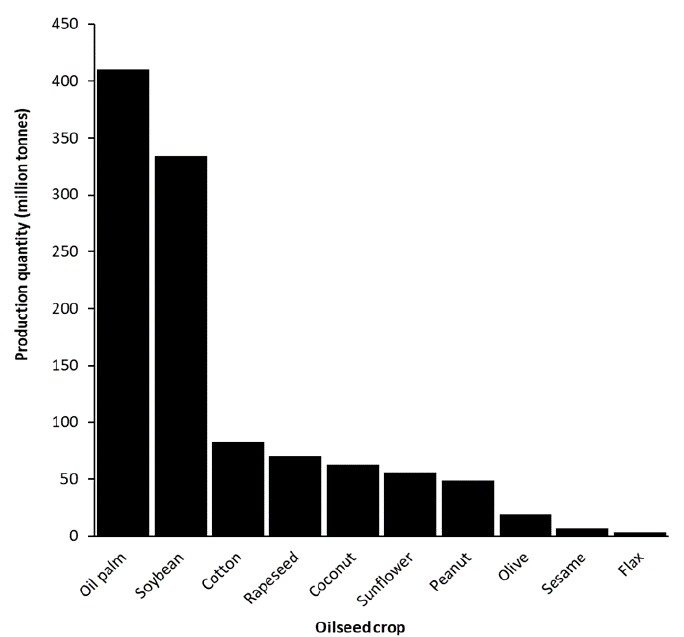
Figure 3. Rapeseed (including canola) was the fourth largest oil crop in 2019 based on global production quantity (data source: FAOSTAT, Food and Agriculture Organization of the United Nations, accessed January 2021).